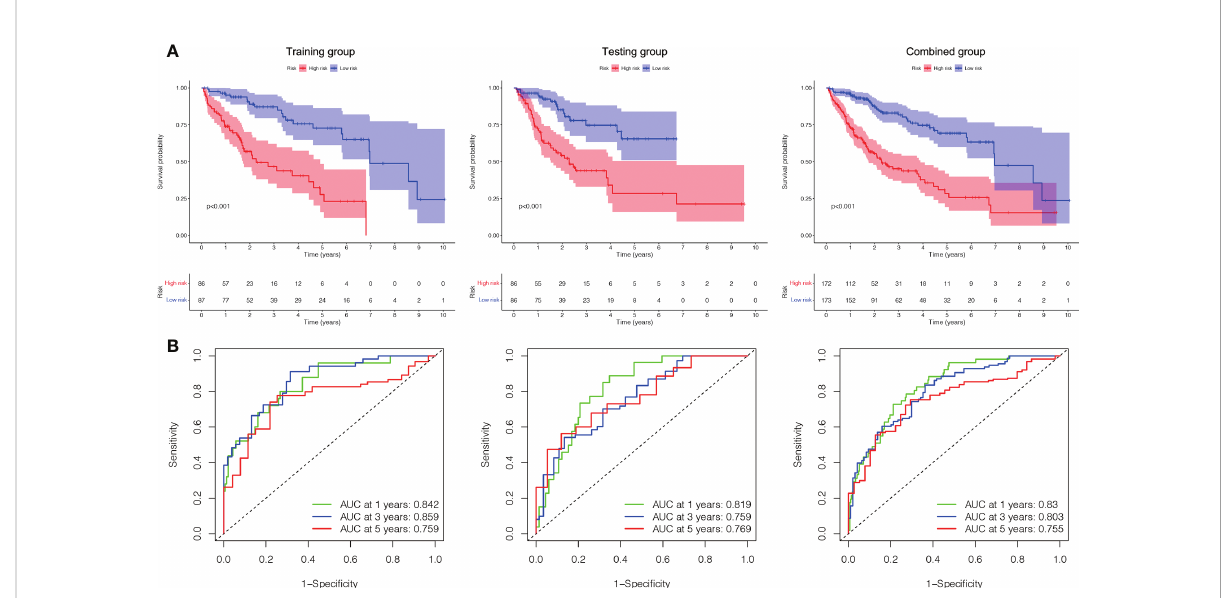
FIGURE 6 Internal validation of the ALPS for OS according to the entire TCGA database. (A) Kaplan-Meier survival curve in the training, testing and combined groups. (B) ROC curve and AUCs at one-year, three-years and fi ve-years survival in the training, testing and combined groups. ALPS, AME-associated lncRNAs prognostic